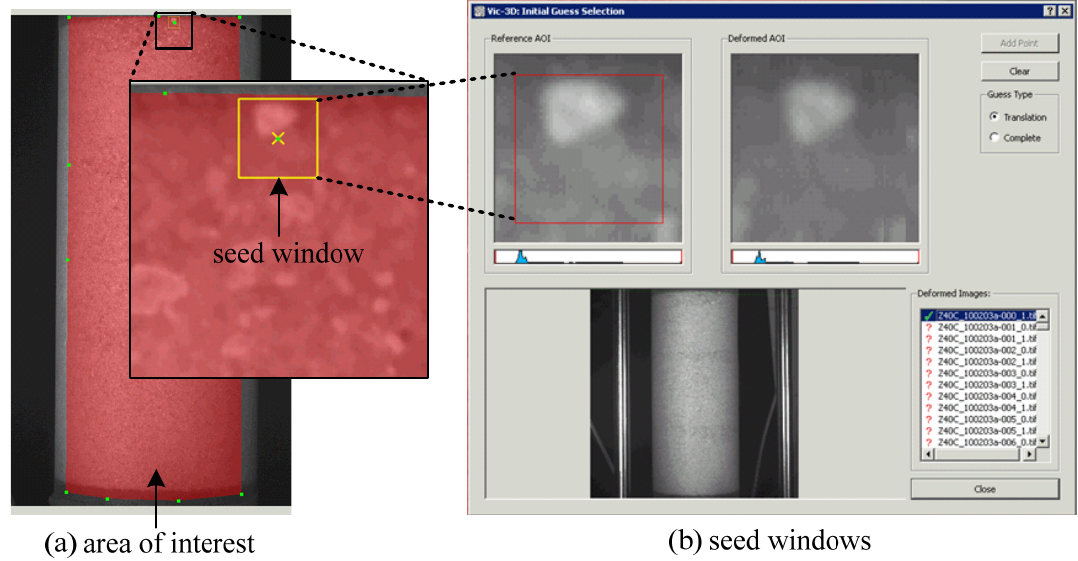
Figure 9. Reference image: area of interest ( a ) and seed windows as produced by (VIC-3D) ( b ).